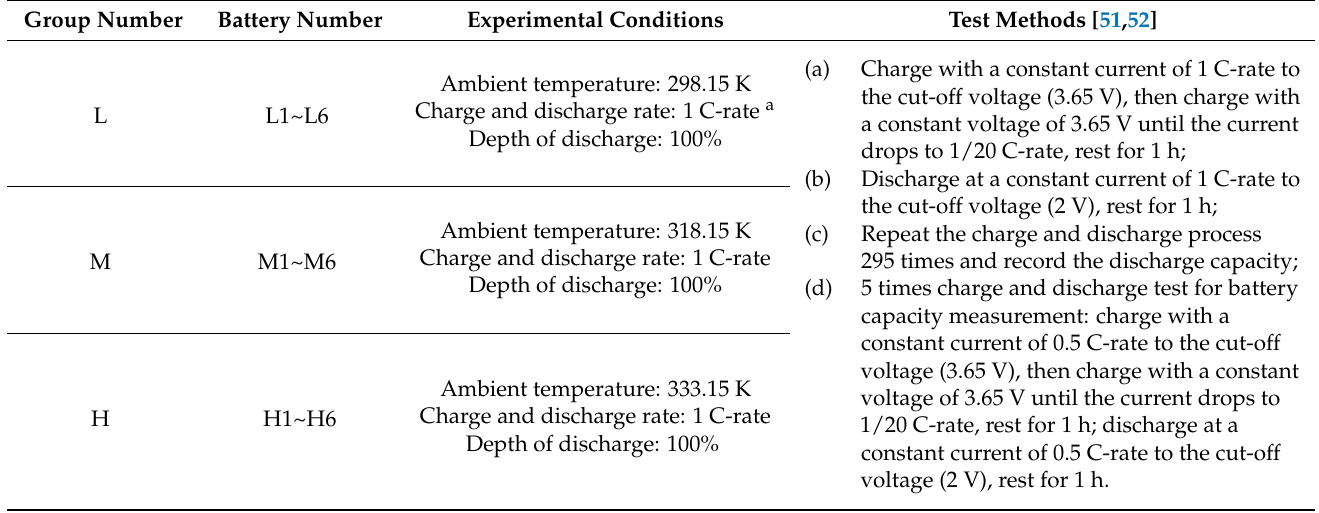
Table 1. Experimental scheme for capacity degradation.